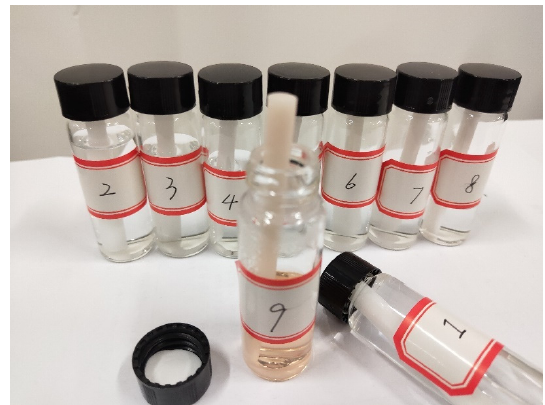
Figure 6. Scent bottles with a cotton swabs.